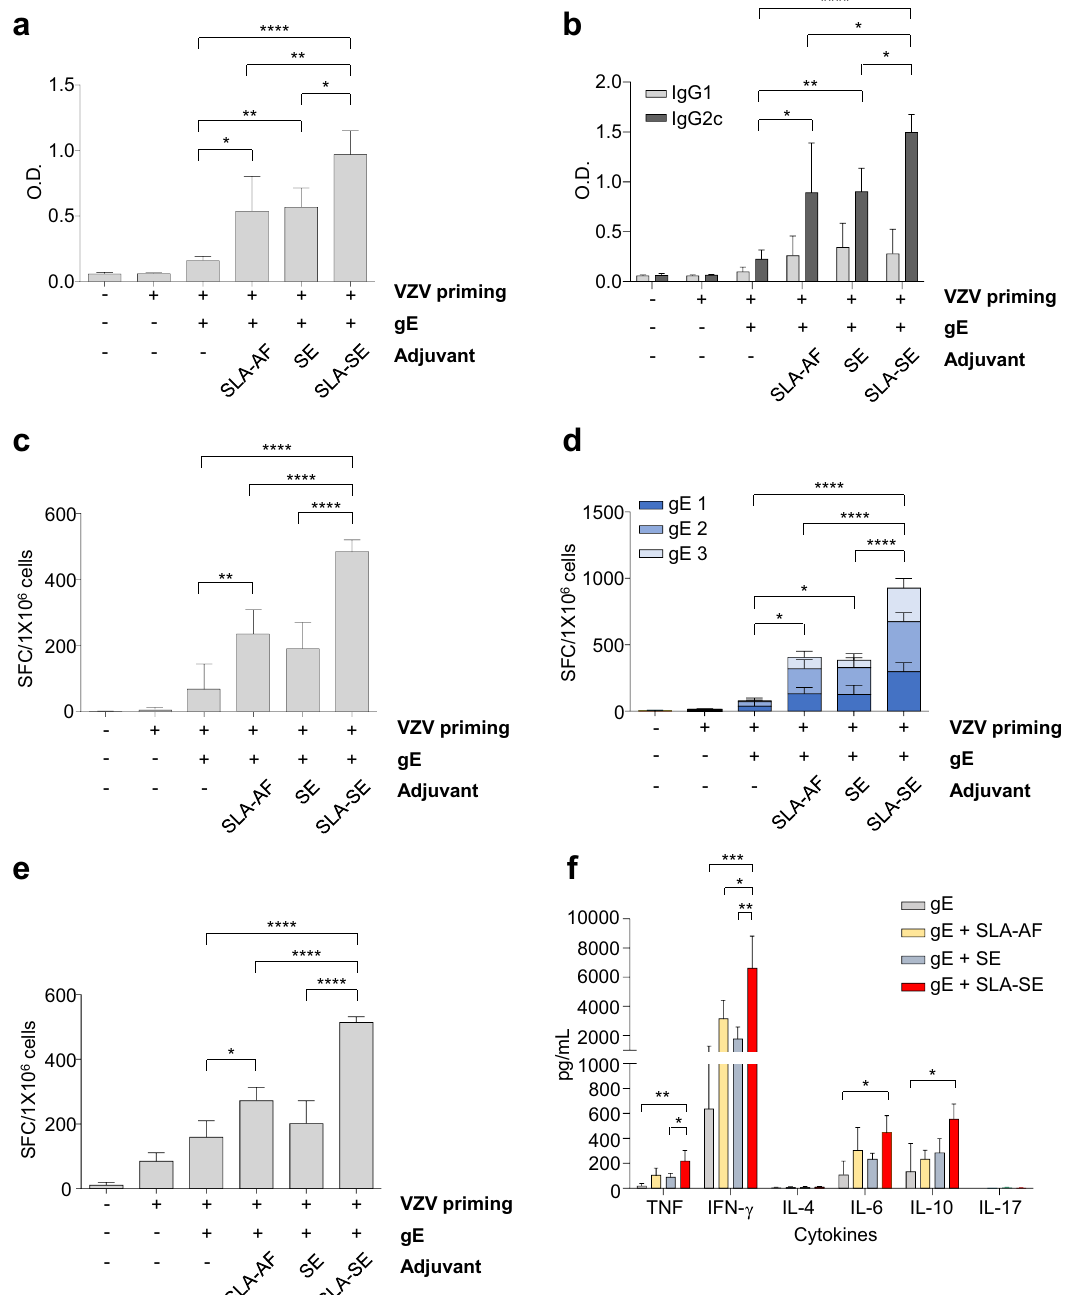
Fig. 1 gE- and VZV-speci fi c immune responses induced by gE/SLA-AF, gE/SE, or gE/SLA-SE. C57BL/6 mice were primed with live attenuated VZV, and then immunized once with gE (5 µg), gE (5 µg)/SLA in aqueous formulation (SLA-AF, 5 µg of SLA), gE (5 µg)/oil-in-water emulsion (SE, 2% oil), or gE (5 µg)/SLA-SE (5 µg SLA in 2% oil) 4 weeks later. Two weeks after immunization, serum was obtained from immunized mice to examine humoral immunity and spleen cells prepared to examine cell-mediated immunity. a gE-speci fi c total IgG antibody response by IgG ELISA using 100,000-fold diluted serum samples from immunized mice. b gE-speci fi c IgG1 and IgG2c antibody response by IgG ELISA using 100,000-fold diluted serum from immunized mice. c – e Antigen-speci fi c, IFN- γ -producing T-cell populations were detected by mouse IFN- γ ELISPOT assay using spleen cells from immunized mice upon antigenic stimulation with c gE protein, d three pools of 62 gE OLPs (15-mer, 5-mer overlap): gE 1 (20 peptides), gE 2 (20 peptides), and gE 3 (22 peptides) or e VZV-infected cell lysate. f Measurement of cytokine secretion upon re-stimulation with gE OLP by cytometric bead array assay. Data are presented as means and standard deviations. * P < 0.05, ** P < 0.01, *** P < 0.005, **** P < 0.001 (ordinary one-way ANOVA). n = 4 mice per